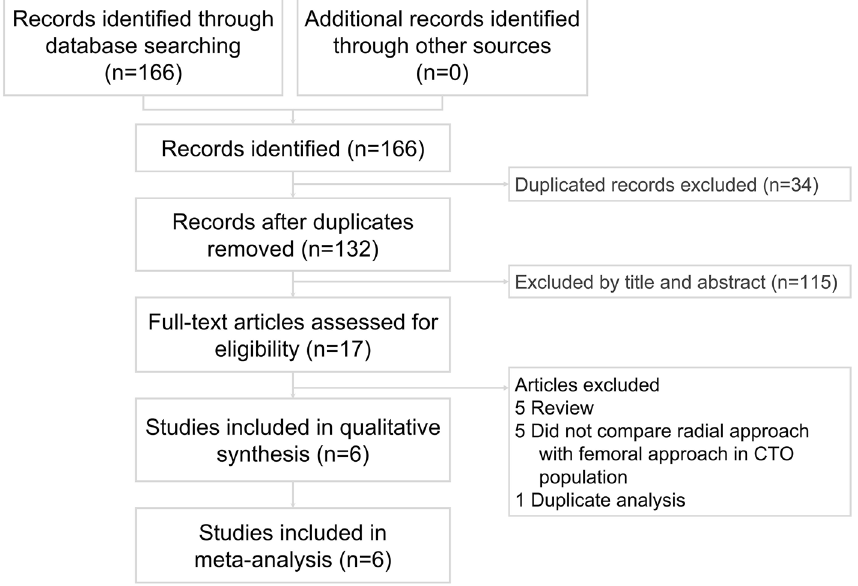
Figure 1. Flowchart of the selection strategy and inclusion and exclusion criteria for this meta-analysis. CTO chronic total